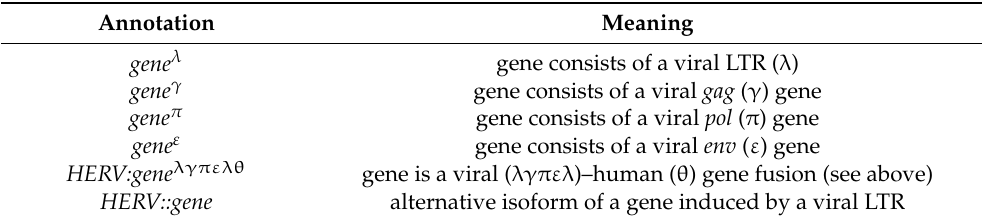
Table 1. Annotations used in this review. Greek letters serve as abbreviation and denote complete or partial viral origin of a gene, RNA, or